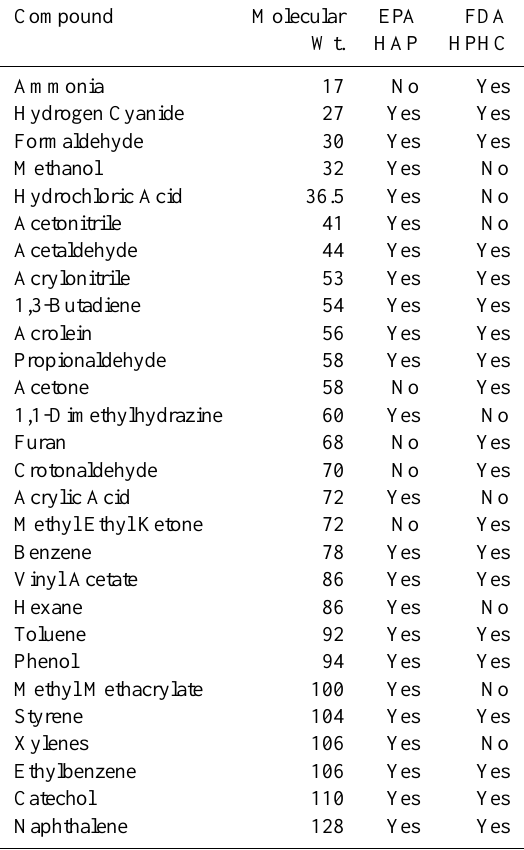
Table 4. The list of compounds identified in this study that are also considered either hazardous air pollutants (EPA) or harmful and po- tentially harmful constituents in tobacco smoke